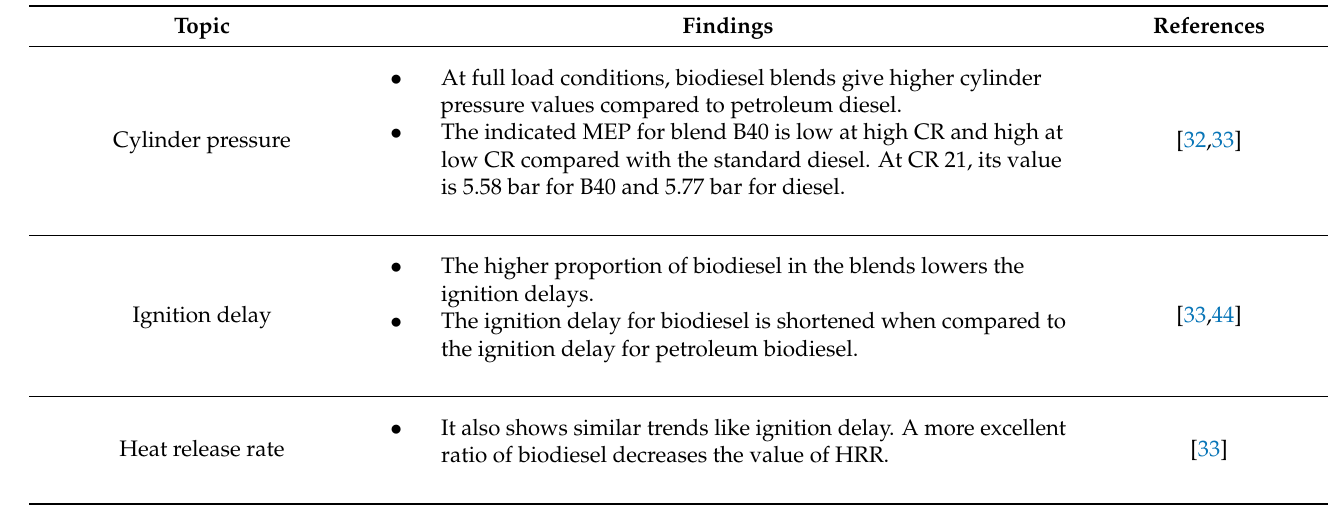
Table 3. Combustion characteristics of waste cooking oil biodiesel blended with diesel fuel in diesel engines. Topic